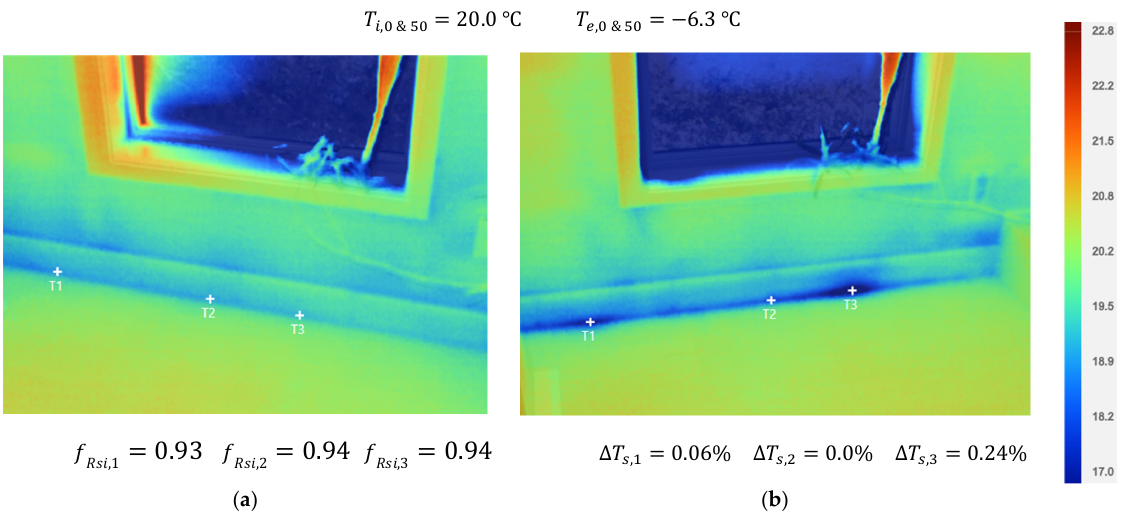
Figure 12. Thermographic analysis of House A and its new concept 2 sealing method at 0 Pa ( a ) and 50 Pa ( b )—photo taken inside house A of a junction of external walls with intermediate floor.